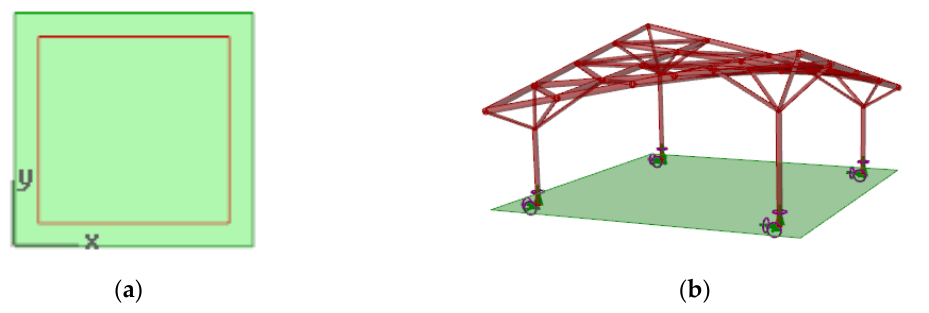
Figure 5. Presentation of the allowed area of supports' positions: ( a ) a horizontal projection; ( b ) a perspective view